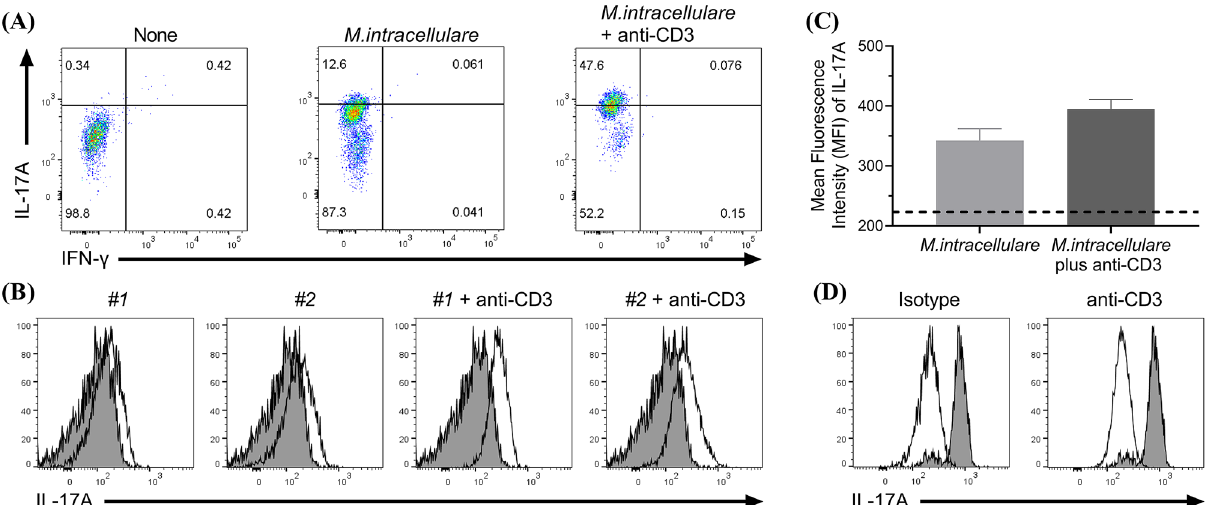
Figure 6. IL-17- and IFN-γ-producing CD4 + T cells according to M. intracellulare infection and anti-CD3 stimulation. ( A ) Representative frequency of IL-17- or IFN-γ- producing canine CD4 + T cells in untreated lymphocytes (left), co-cultured with M. intracellulare -infected non-autologous MDMs (middle) or co-cultured with M. intracellulare -infected non-autologous MDMs with the anti-CD3 antibody (right). ( B ) Canine CD4 + T cells were co-cultured with M. intracellulare -infected non-autologous MDMs (#1, #2) and activated with anti-CD3 antibody (#1 + anti-CD3, #2 + anti-CD3). IL-17-expressing CD4 + T cells was analyzed by comparing untreated lymphocytes (filled). ( C ) The mean fluorescence intensity of IL-17 in co-cultured CD4 + T cells with M. intracellulare -infected non-autologous MDMs without ( M. intracellulare ) or with anti-CD3 antibodies ( M. intracellulare plus anti-CD3), respectively. A dotted line indicates the expression of IL-17 in untreated lymphocytes. ( D ) In co-cultured with M. intracellulare -infected non-autologous MDMs with the anti-CD3 antibody, IL-17-expressing CD4 + T cells was analyzed by comparing isotype control (left). The co-cultured cells with non-infected MDMs with anti-CD3 antibody were used as a control modulated. These pathways were modulated by commonly expressed molecules at 6, 24, and 72 h. Among the